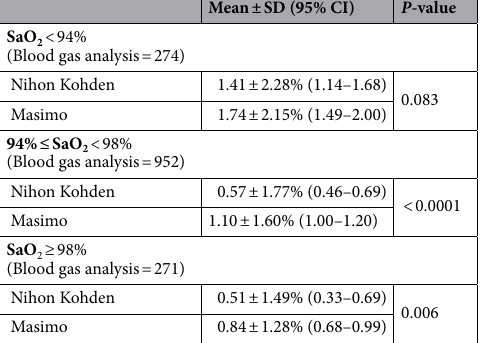
Mean ± SD (95% CI) P